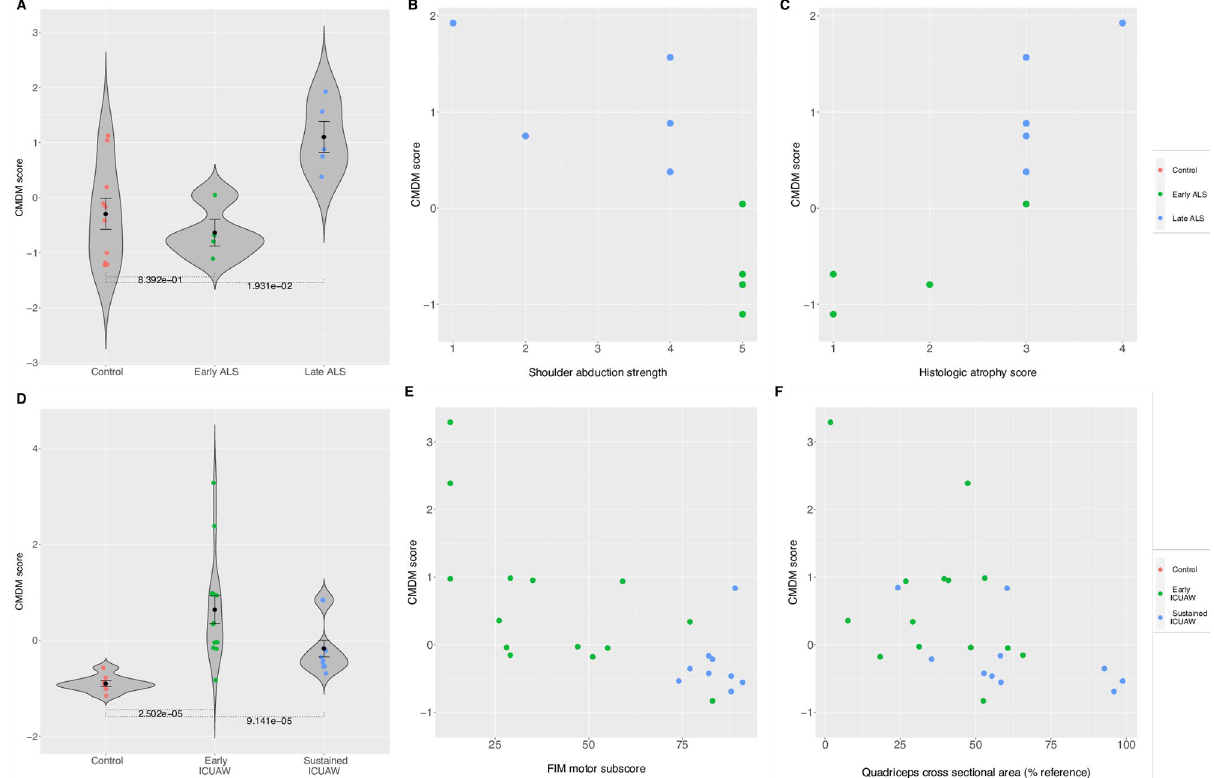
Figure 3. CMDM score significantly associates with clinical and histological severity in ALS and ICUAW. Plots of ( A ) CMDM scores in violin plots for controls, early ALS, and late ALS (EMEXP3260) Error bars show middle quartiles. P-values calculated with Wilcoxon rank-sum test. ( B ) Grading score of muscle atrophy in ALS (based on histology) versus CMDM score. ( C ) Shoulder abduction (muscle strength) versus CMDM score. ( D ) CMDM scores in violin plots for controls, early ICUAW (Day 7 post-ICU), and sustained ICUAW (month 6 post-ICU; GSE78929). ( E ) CMDM scores versus functional independence measure [FIM] motor subscore. ( F ) CMDM score versus quadriceps muscle mass. Each dot corresponds to individual samples. ICUAW ICU acquired weakness, ALS acute amyotrophic lateral